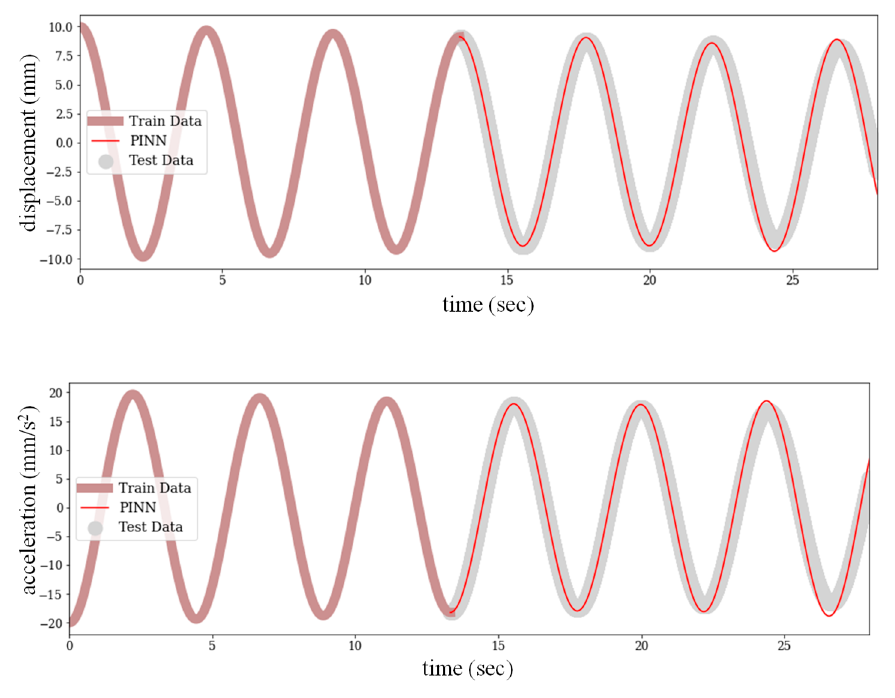
Figure 8. Displacement and acceleration estimation of the SDOF trained by displacement measurements.